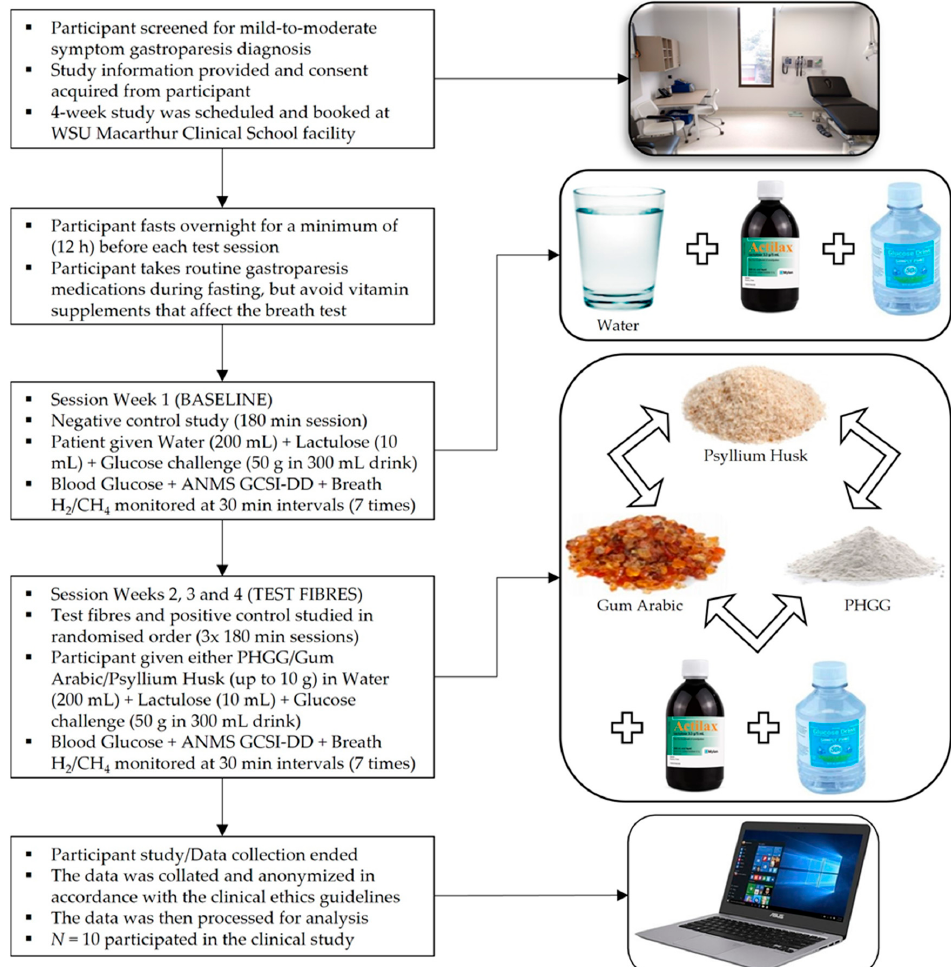
Figure 1. Procedural flowchart for the clinical study.